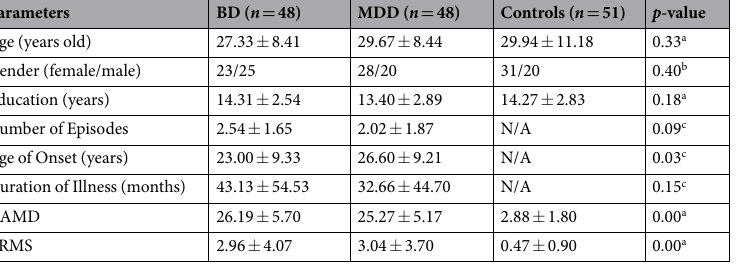
Table 1. Demographics and clinical characteristics of the BD patients, MDD patients, and healthy controls in this study. Abbreviations: BD (MDD), bipolar (major depressive) disorder; HAMD, Hamilton Depression Rating Scale; YRMS, Yong Mania Rating Scale. a The p -value was obtained from permutation ANOVA analysis. b The p -value was estimated obtained from Pearson’s χ 2 -test. c The p -value was calculated from permutation two- sample t test. N/A, not